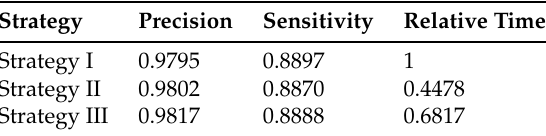
Table 8. Retraining Strategies I–III performance on Passenger